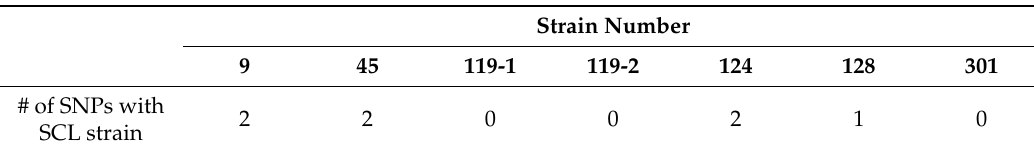
Table 3. Comparative analysis of variants in the genomes of the Chilean B. canis isolates with the SCL